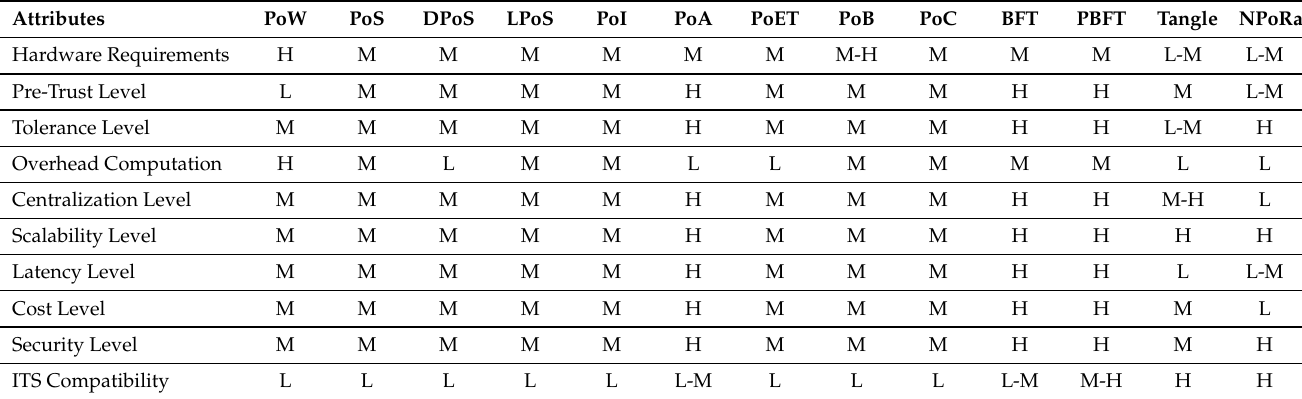
Table 10. Comparative Analysis between Current Consensus Algorithm with Related